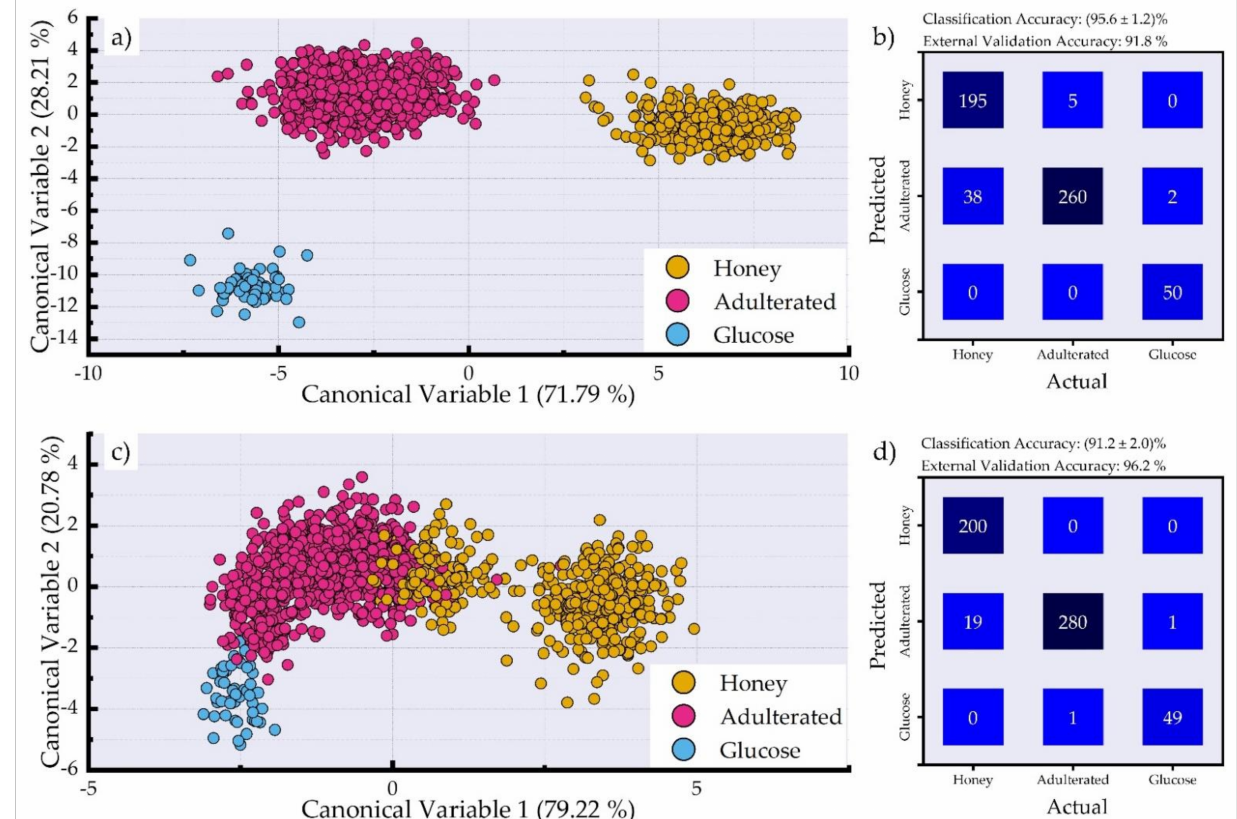
Figure 3. ( a ) LDA canonical variable plot employing the LIBS spectra. ( b ) Confusion matrix showing the prediction of the test samples using the LDA algorithm employing the LIBS spectra. ( c ) LDA canonical variable plot employing only the spectral lines of Ca (II), Na (I), and K (I) (see Figure 2). ( d ) Confusion matrix showing the prediction of the test samples using the LDA algorithm employing only the spectral lines of Ca (II), Na (I), and K